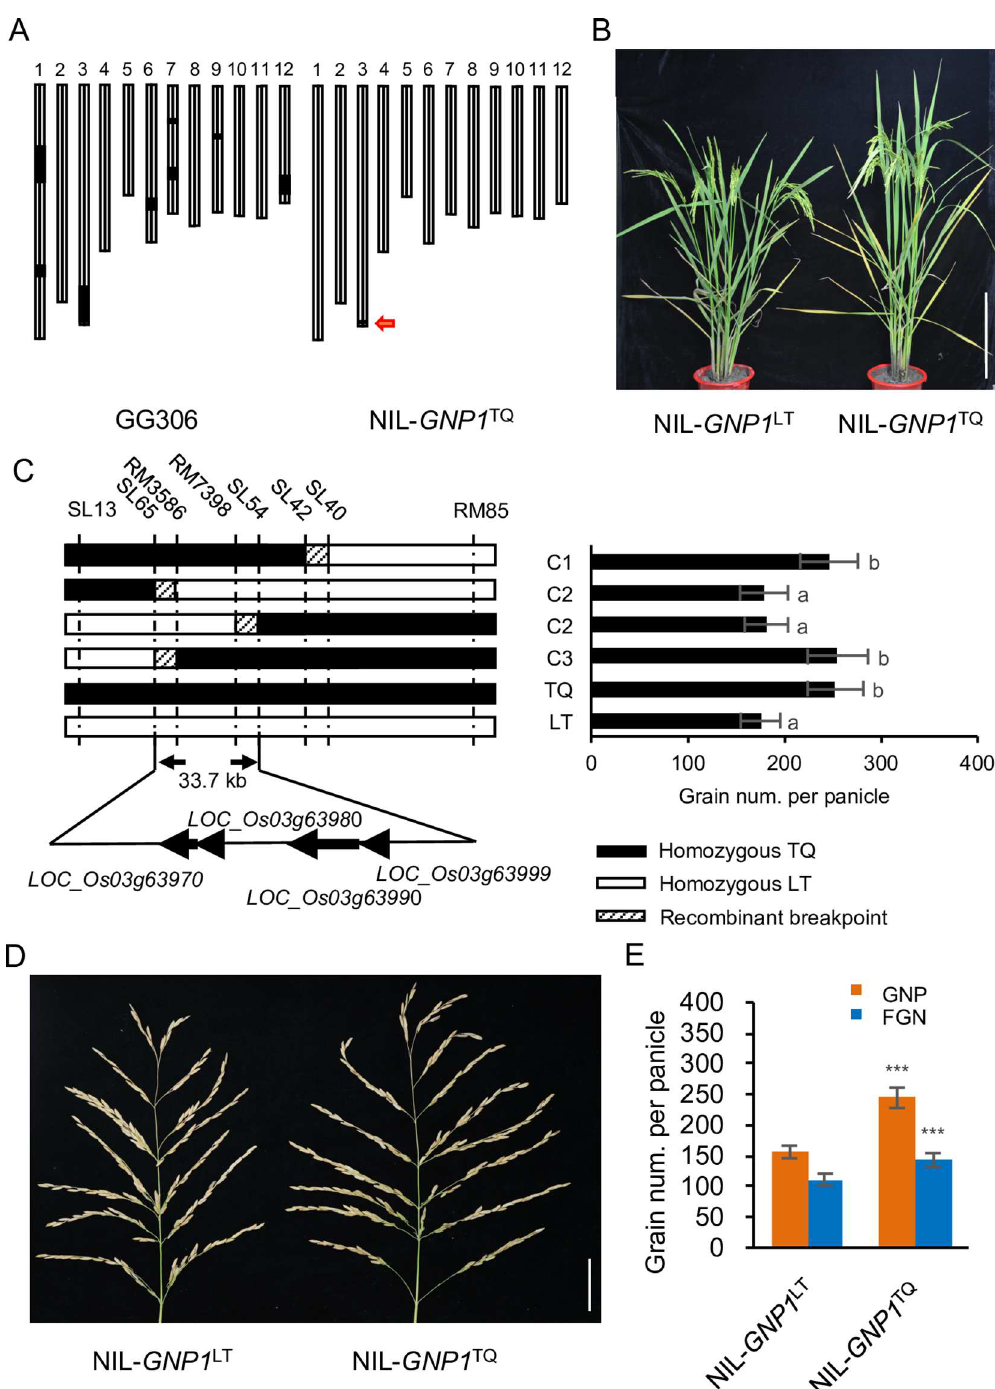
Fig 1. Characterization and map-based cloning of the GNP1 QTL. (A) Graphical genotype of GG306 and NIL- GNP1 TQ . NIL- GNP1 TQ containedthe Teqing (TQ) allele at GNP1 in the 66.1 kb region on chromosome 3. Black bars, genome fragments from TQ; white bars, genome fragments from LT. (B) Gross morphology of NIL- GNP1 LT and NIL- GNP1 TQ . Scale bar, 40 cm. (C) High-resolution mappingof the GNP1 locus. Black, white and lightly shaded rectanglesindicate the homozygous TQ genotype, homozygous LT genotype and marker intervals containingrecombination breakpoints, respectively. Different letters (a, b) indicate significant difference determinedby the Fisher’s least significant difference (LSD) method at p -value < 0.01 (n = 40 plants). (D) Panicle morphology of NIL- GNP1 LT and NIL- GNP1 TQ . Scale bar, 5 cm. (E) Comparison of GNP and FGN between